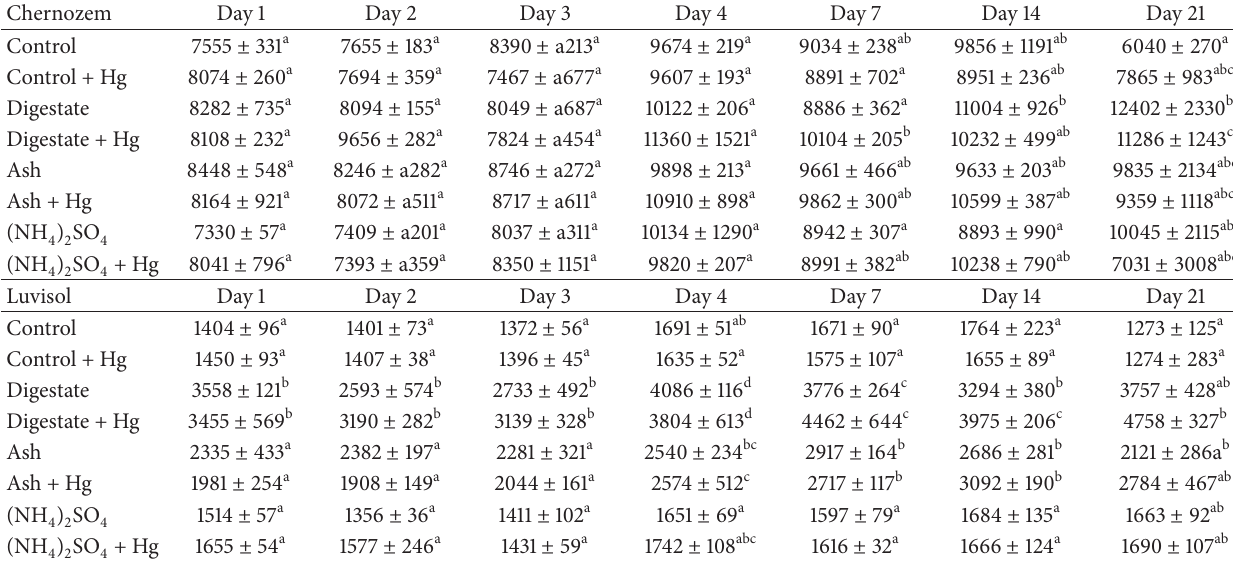
Table 3: The concentrations of Ca extractable with 0.11mol L − 1 acetic acid within the incubation experiment (mg ⋅ kg − 1 ); the averages marked by the same letter did not significantly differ at 𝑃 < 0.05 within individual columns; data are presented as mean ± standard deviation ( 𝑛 = 3 ).